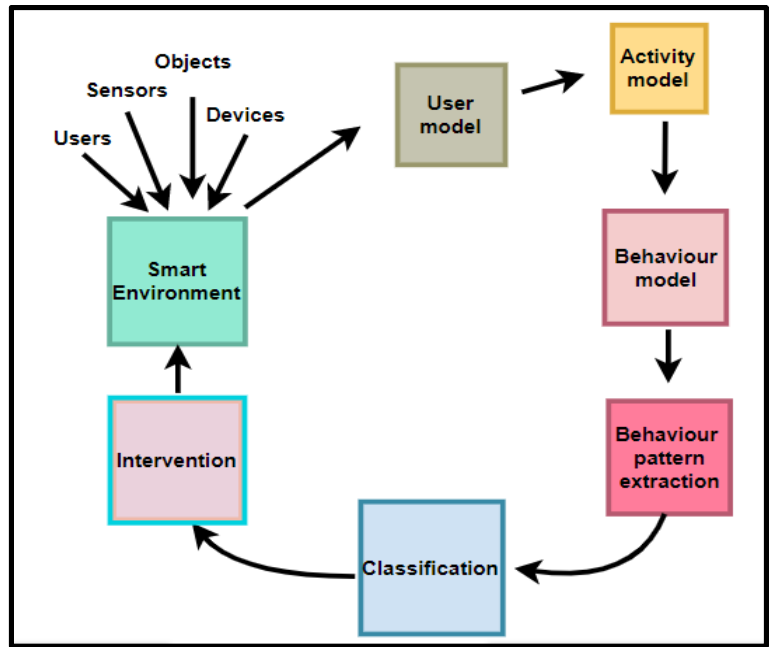
Figure 1. The Positive Behaviour Change Model v.1.